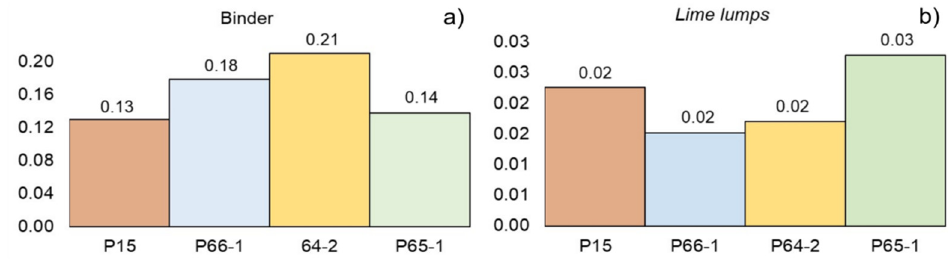
Figure 5. Hydraulicity index (HI) values for binder ( a ) and lime lumps ( b ) of mortar